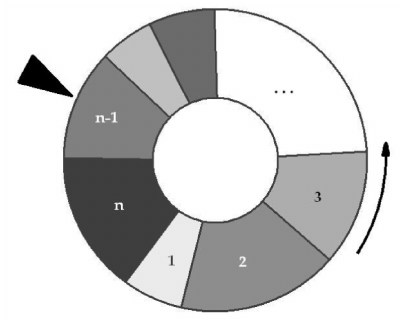
Fig. 3 Roulette-wheel illustration